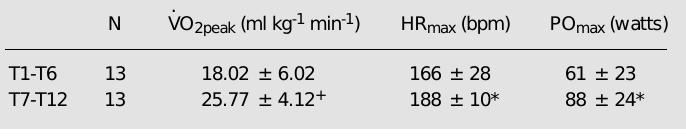
Table 2 - Physiological characteristics of paraplegic subjects divided according to the level of spinal cord injury. V. O 2peak : Peak oxygen uptake; HR max : maximal heart rate; PO max : maximal power output. *P<0.02, + P<0.01 compared to T1-T6 ( t -test).